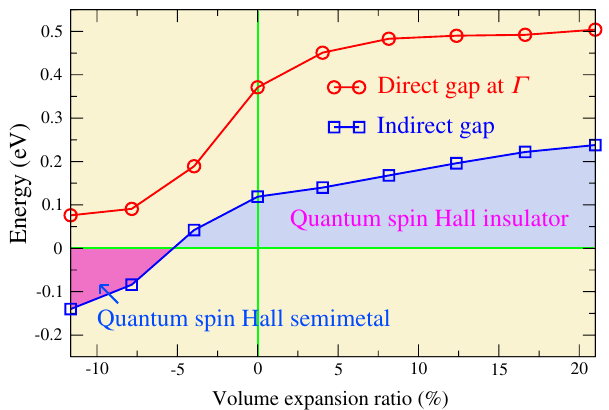
FIG. 5 (color online). The calculated band gaps of single-layer ZrTe 5 as a function of volume change. Both the direct gap at Γ and the indirect band gap are shown. The nontrivial Z 2 topology survives as long as the band gap at Γ remains